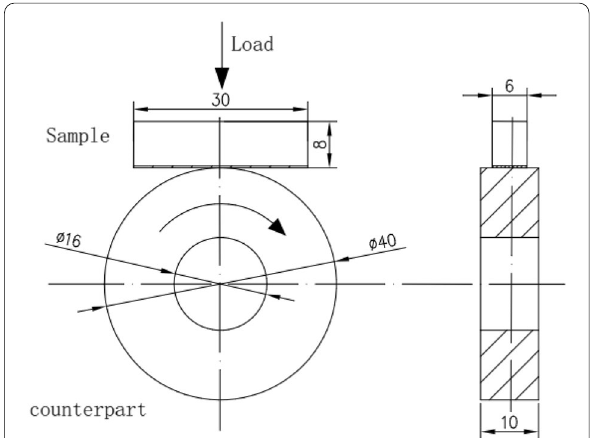
Figure 5 Schematic of ring–block friction and wear test